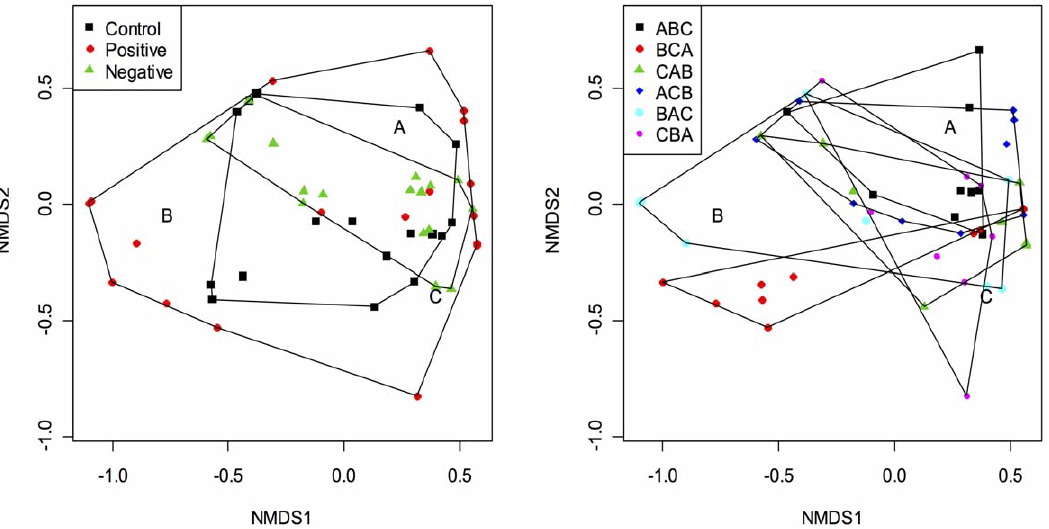
Figure 4. Nonmetric multidimensional scaling (NMDS) ordination plots of community composition. Left, effects of introduction density; right, effects of introduction sequence. Each symbol represents the composition of a protozoan community in an experimental microcosm, and the distance between any two points represents the difference between those two communities according to the Bray-Curtis dissimilarity metric. Letters within plots represent the locations of species A, B, and C scores in two-dimensional space. Lines represent the minimum convex hulls around the data. The stress value for the ordination was 3.29. All the combinations of the density treatments differed highly significantly in community dispersion (Table 2a). Differences in the means of community dispersion between sequence treatments were significant by Tukey’s HSD significance test in the combinations of ABC/BCA, ABC/BAC, BCA/CAB, BCA/ACB, CAB/BAC, and ACB/BAC (Table 2b).